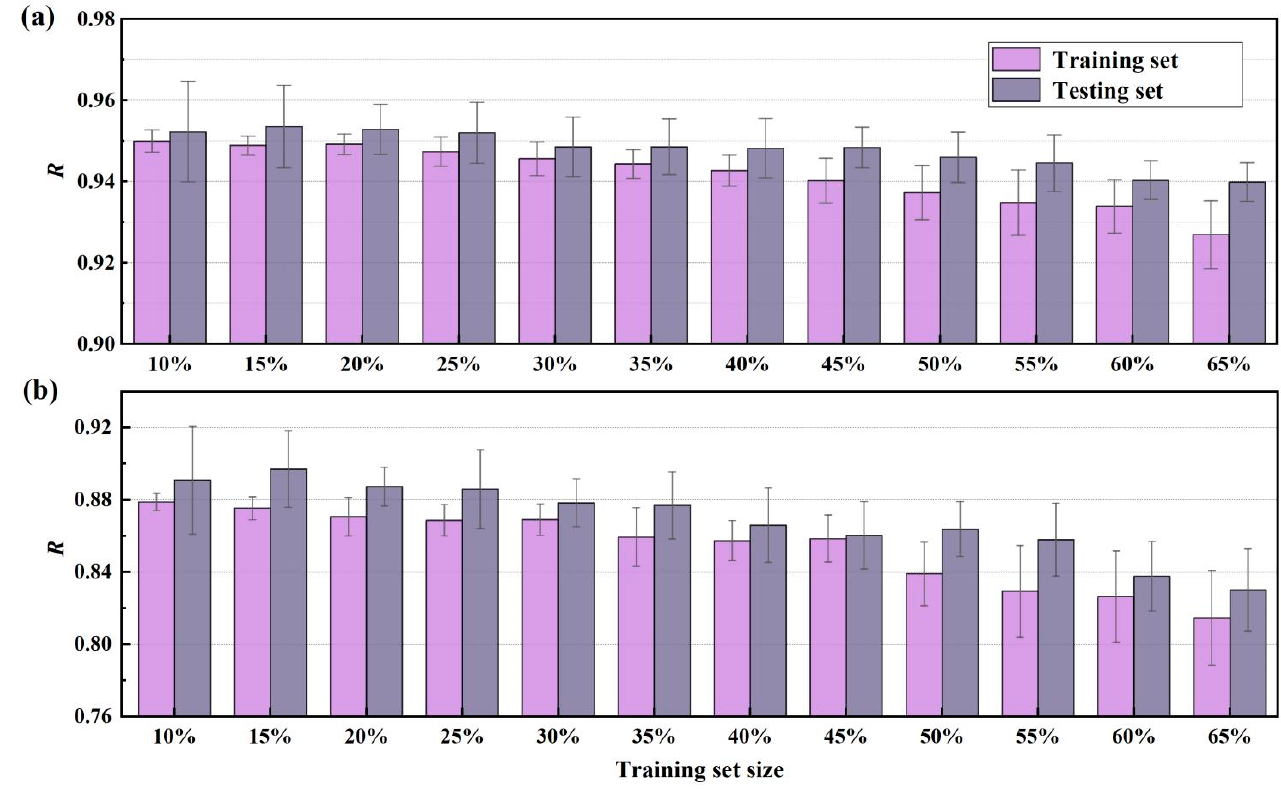
Figure 5. Influence of testing set size on the RF performance: ( a ) dataset 1 and ( b ) dataset 2.